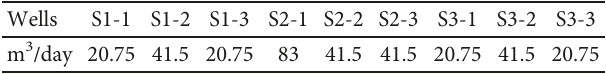
Table 1: The liquid volume quantity of production wells.